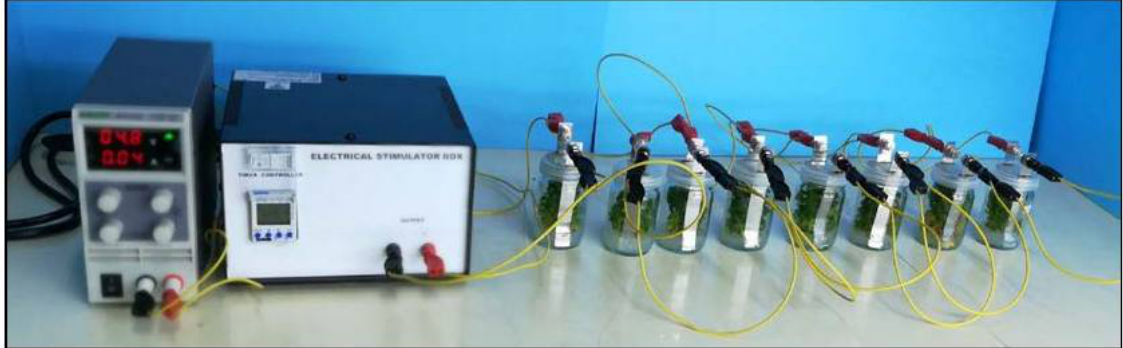
Figure 2. Experimental study for electrical stimulation on 5-month-old tissue culture plants of O. ridleyana .